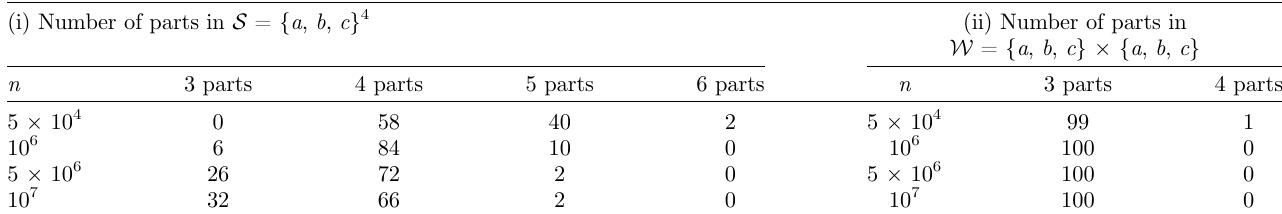
Table 3. Number of parts of the partitions estimated for settings (i) and (ii) in 100 simulations of size n each. (i) Number of parts in S = { a , b , c } 4